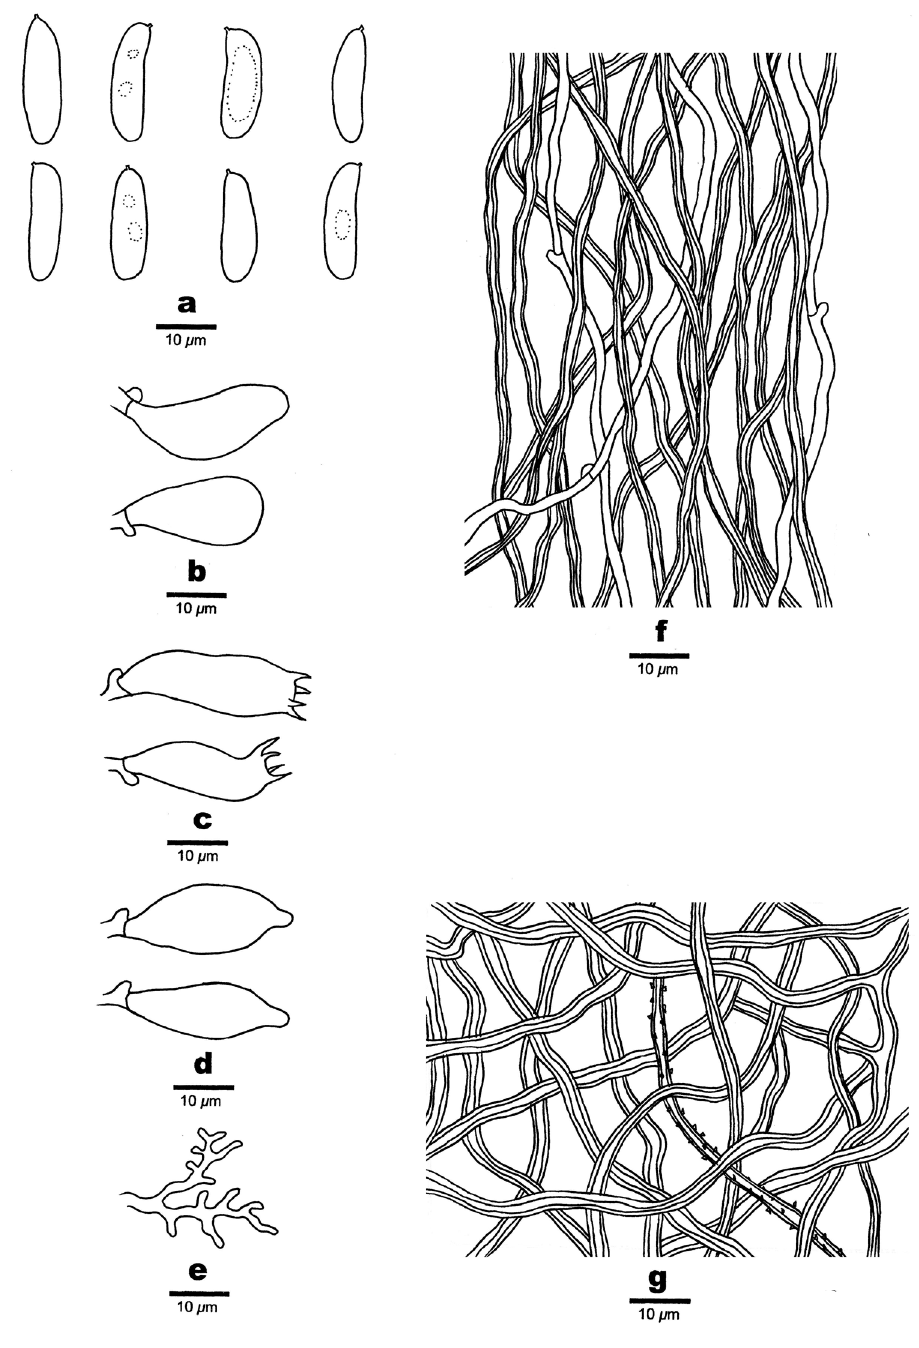
Figure 2. Microscopic structures of Megasporia rimosa sp. nov. (drawn from the holotype). a Basidiospores b Basidio les c Basidia d Cystidioles e Dendrohyphidia f Hyphae from trama. g. Hyphae from